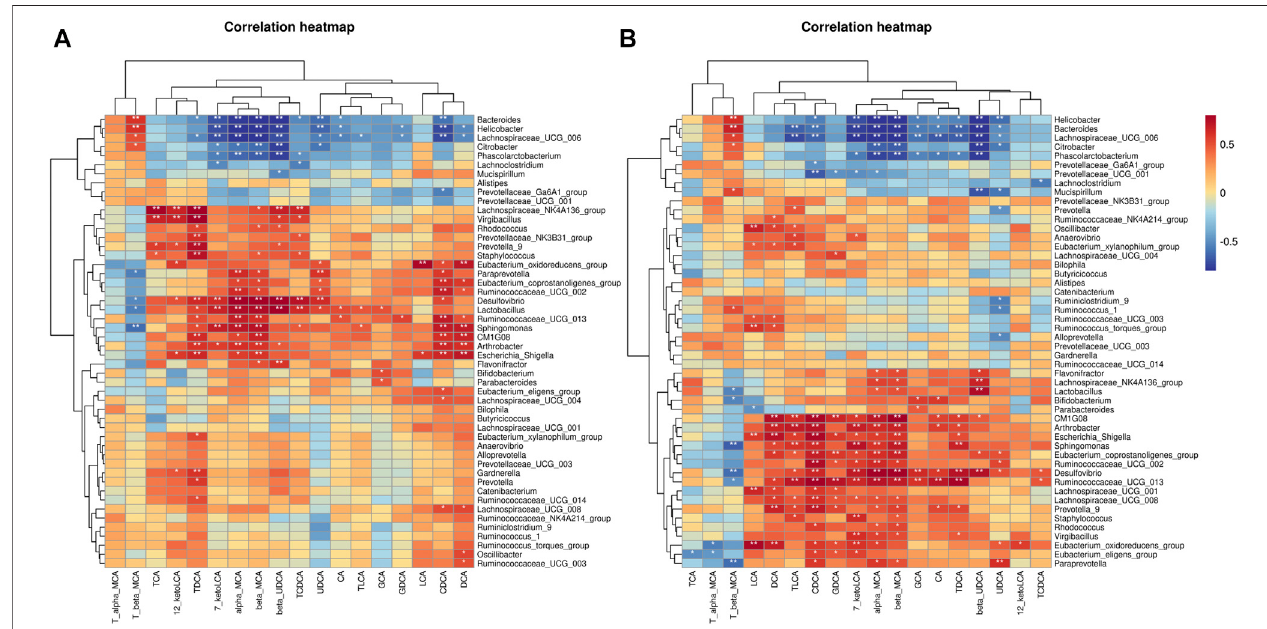
FIGURE11| CorrelationanalysisofBAsspecieswithIMspeciesinmice. (A) BasedonPearson'scorrelationcoef fi cient. (B) BasedonSpearman'srankcorrelation coef fi cient.